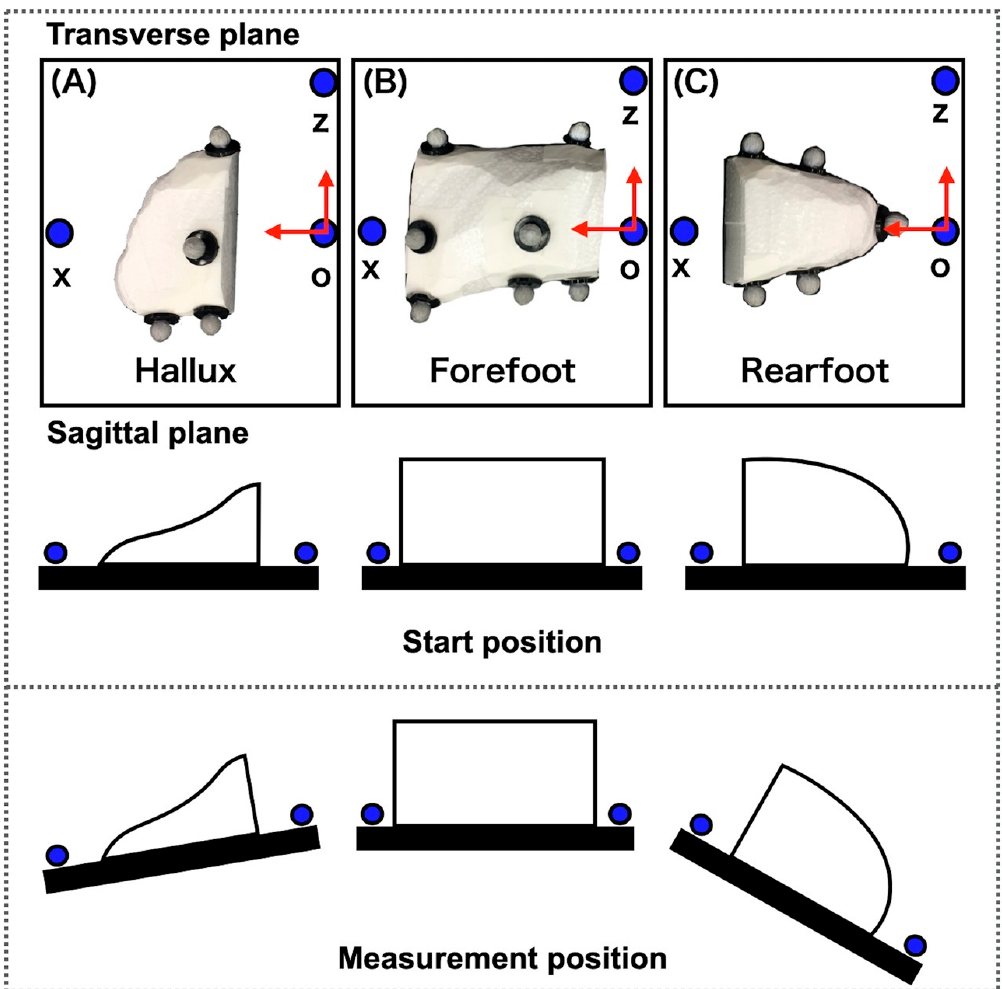
Figure 3. Three infrared-reflecting markers (point o, point x, and point z) were attached, respectively, to the three plates that were placed on each dummy foot to calculate the true value. The X and Z axes (red solid arrows) on these plates were shown. Angles for the plates were defined as the true values for the corresponding joint angles; the angle of plate ( A ) relative to plate ( B ) corresponded the Hallux relative to forefoot (Met_Hal) angle and the angle of plate ( B ) relative to plate ( C ) corresponded the forefoot relative to rearfoot (Cal_Met) angle. Measurement positions were from − 90 to 90 degrees in all planes.